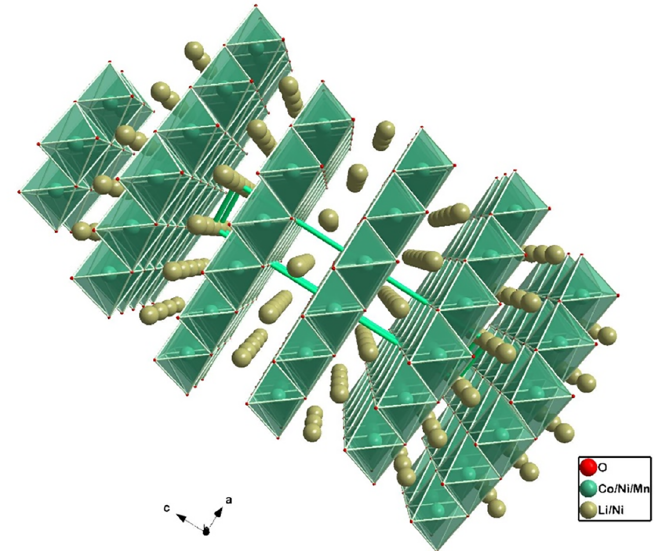
Figure 8. Rhombohedral (layered) structure for NMC811. Space group: R-3m.